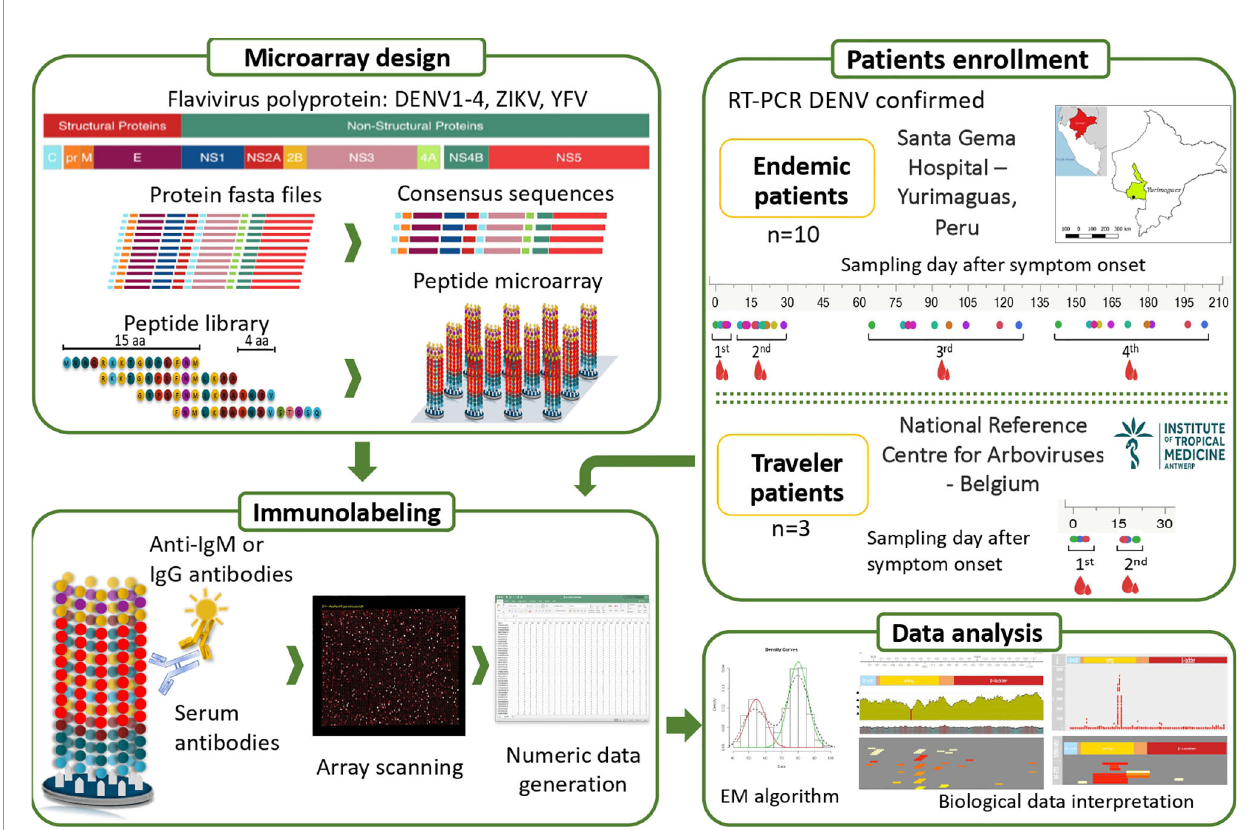
FIGURE 1 | Overview of the study design. Two groups of febrile patients: (i) endemic individuals coming from the Peruvian Amazon and (ii) Belgian returning travelers were enrolled. DENV infection was con fi rmed by RT-PCR. Four blood samples were collected over six months after symptom onset in the endemic group and two samples within a month after onset of symptoms in the traveler group. The bioinformatic analysis to design the peptide microarray included downloading fasta fi les from the ViPR database https://www.viprbrc.org, representing a wide geographical coverage of DENV, ZIKV, YFV and CHIKV. Based on the conservation degree of the analysed sequences and the AA properties, one or multiple sequences per virus, lineage and protein were obtained with optimal global coverage, which were fi nally used to generate the peptide library. The 284 unique sequences were broken up into 9,023 peptides, each of 15 amino acids (aa) length tiling every 4 AA across the DENV, ZIKV, YFV and CHIKV proteomes. The synthetized peptide library was mixed with sera containing antibodies that bind to their cognate epitope on the peptide. Bound antibodies were stained with either anti-IgG – or anti-IgM – secondary antibodies. Lastly, the peptide microarrays were scanned and the image fi les were converted to numeric data. Cut-offs were calculated per sample using the expectation maximization (EM) algorithm and the data was used for further